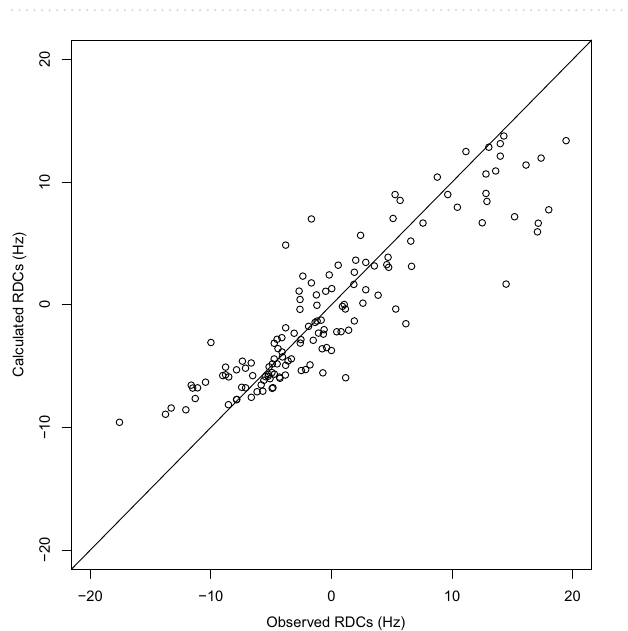
Figure 4. Comparison of the calculated and experimental residual dipolar coupling (RDC) values. The RDC values have been calculated with the software PALES 2.1 33 on the conformations 12, 13, 24, 140, 176 and were averaged using the populations determined in Fig. 3. The plot was prepared using R 3.4.1 58